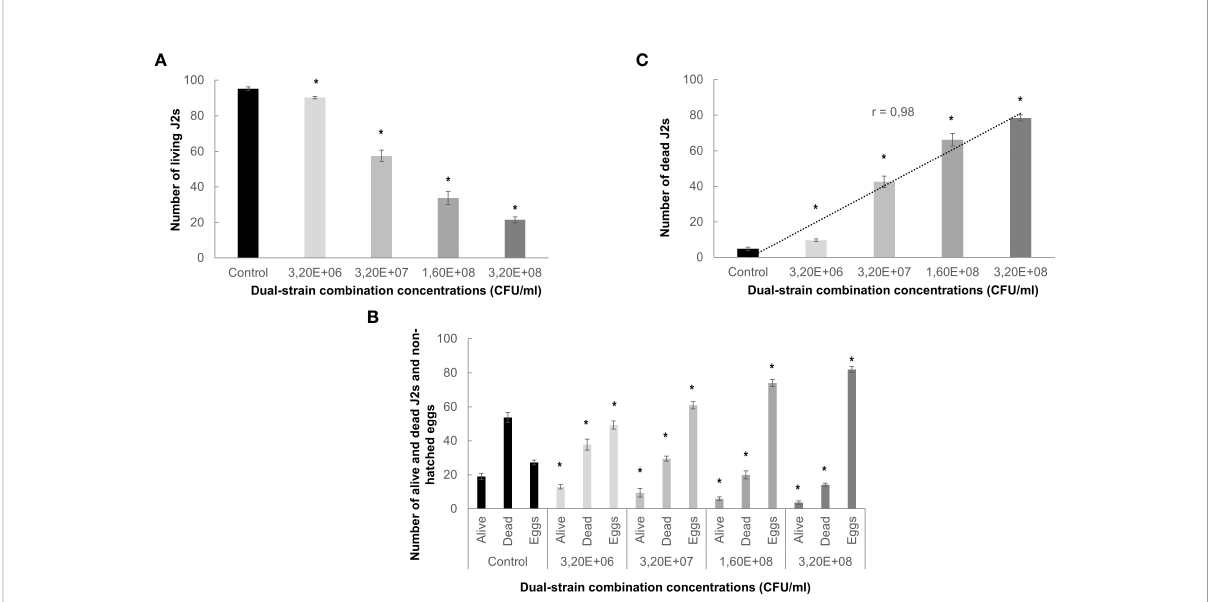
FIGURE 1 Effect of bacterial treatments on the mortality and hatching of Meloidogyne javanica . (A) Number of living J2s nematodes relative to the control for each treatment is represented in the Y axis. Nematodes were monitored after 96 hours. (B) Number of alive and dead J2s, and non-hatched eggs respect to the control for each treatment are represented in the Y axis. Eggs hatching was counted 10 days after incubation. 10mM magnesium sulfate was used as control. Four independent replicates of 100 eggs or J2s each were tested per treatment in three independent experiments. Dilutions from 1x of dual-strain bacteria combination ( B. paralicheniformis FMCH001 and B subtilis FMCH002, 3,20E+08 CFU/ml), are indicated in the X axis. 1x is 3,20E+08 CFU/ml; 1/2x is 1,60E+08 CFU/ml; 1/10x is 3,20E+07 CFU/ml; 1/100x is 3,20E+06 CFU/ml. (C) Pearson correlation coef fi cient (r) between J2s mortality (y-axis) and the bacteria dilutions (x-axis) was 0,98, p<0.003. Bars represent mean ± SE. *Asterisks, signi fi cant differences respect to control (t-test; P<0.05). CFU is considered as the number of